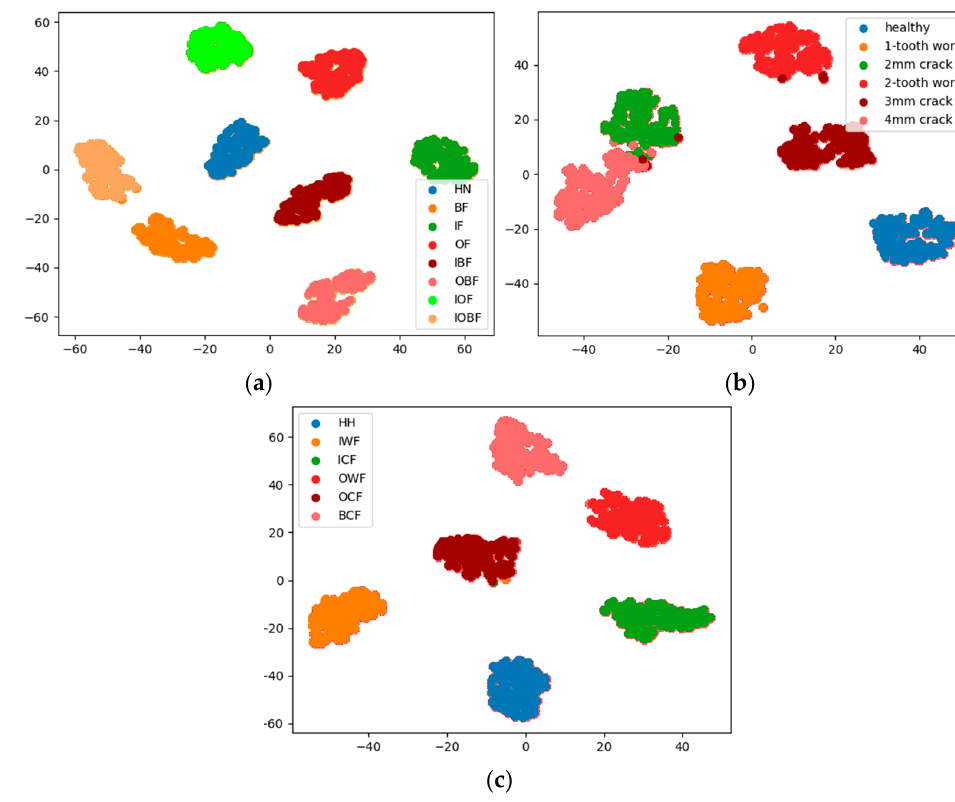
Figure 11. AMC-RSN with visualization of t-SNE. ( a ) Case I. ( b ) Case II. ( c ) Case III.